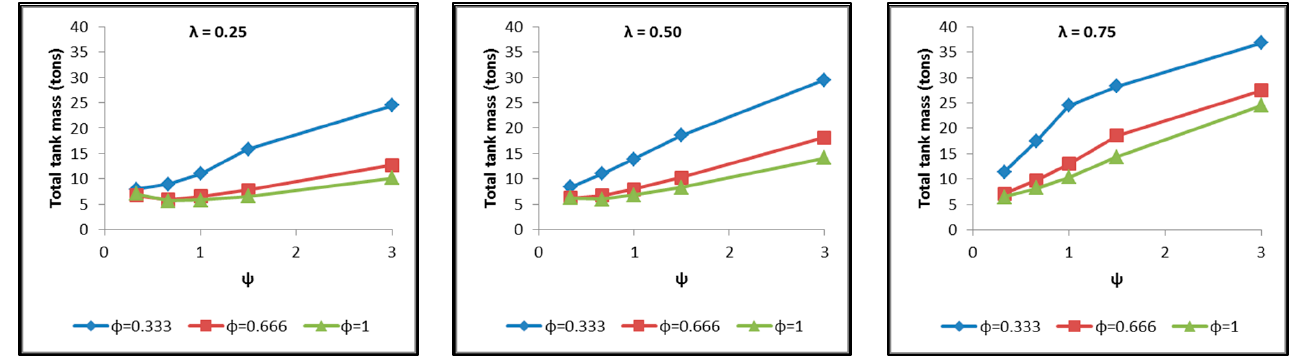
Figure 21. Distribution of total tank mass as a function of the ratios λ , φ and ψ .